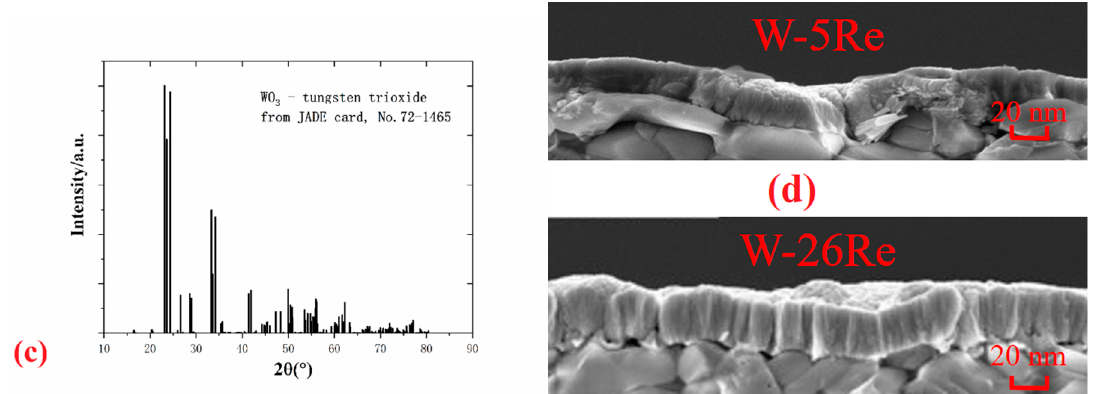
Figure 6. XRD patterns of W-5Re ( a ) and W-26Re thin-film and coated thin-film at di ff erent temperatures ( b ), XRD standard card ( c ) of WO 3 , and SEM section image ( d ) of W-5Re with coating layer. The oxidation and compositional changes of the tungsten-rhenium TFTC ultimately a ff ect the thermoelectric properties, including the Seebeck coe ffi cient and repeatability error, and lead to the failure of TFTCs, which is shown in Figure 7a. A coating layer process can not only avoid the TFTCs from being oxidized but ensure its Seebeck e ff ect to yield a thermoelectric voltage at 1420 shown in Figure 7b.